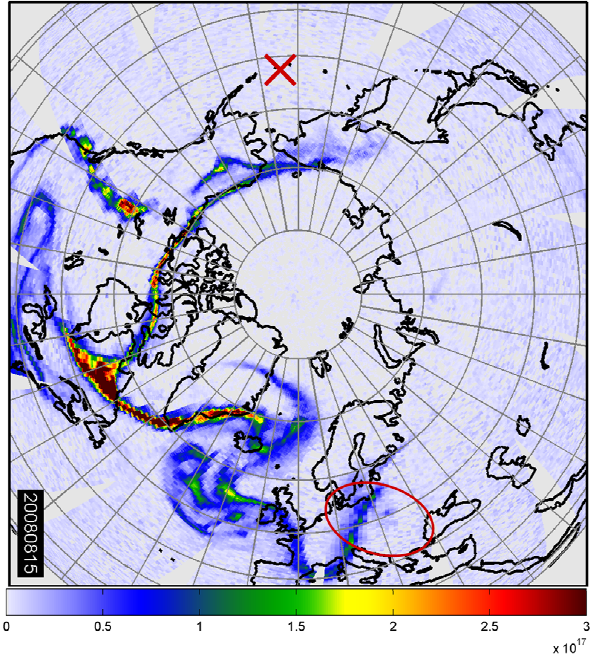
Fig. 3. Distribution of the Kasatochi SO 2 plume (mostly north of 40 ◦ ) one week after the eruption (15 August 2008) based on GOME-2 VCD, the colour scale ranges from 0 to 3 × 10 17 molec/cm 2 . The cross indicates the position of the Kasatochi volcano (Aleutian Islands, Alaska, 52.17 ◦ N, 175.51 ◦ W). The part of the plume discussed in the paper is indi- cated by the red